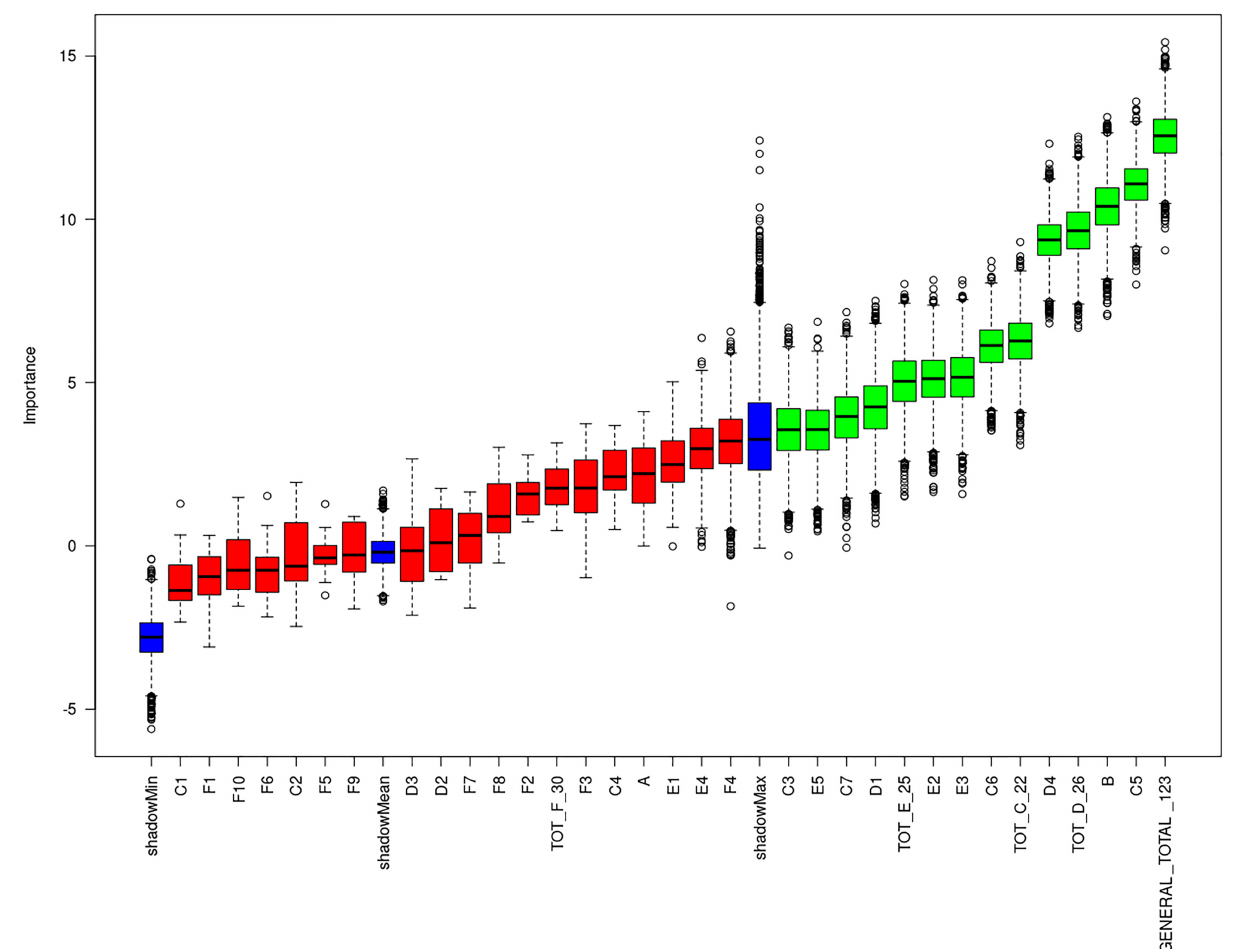
FIGURE 4 | Plot of Boruta feature selection process for the “intensive psychological support” outcome: the red boxes represent the not relevant items, the yellow are the uncertain ones, the green are the relevant items. Blue boxes are calculated as reference levels during the run of Boruta